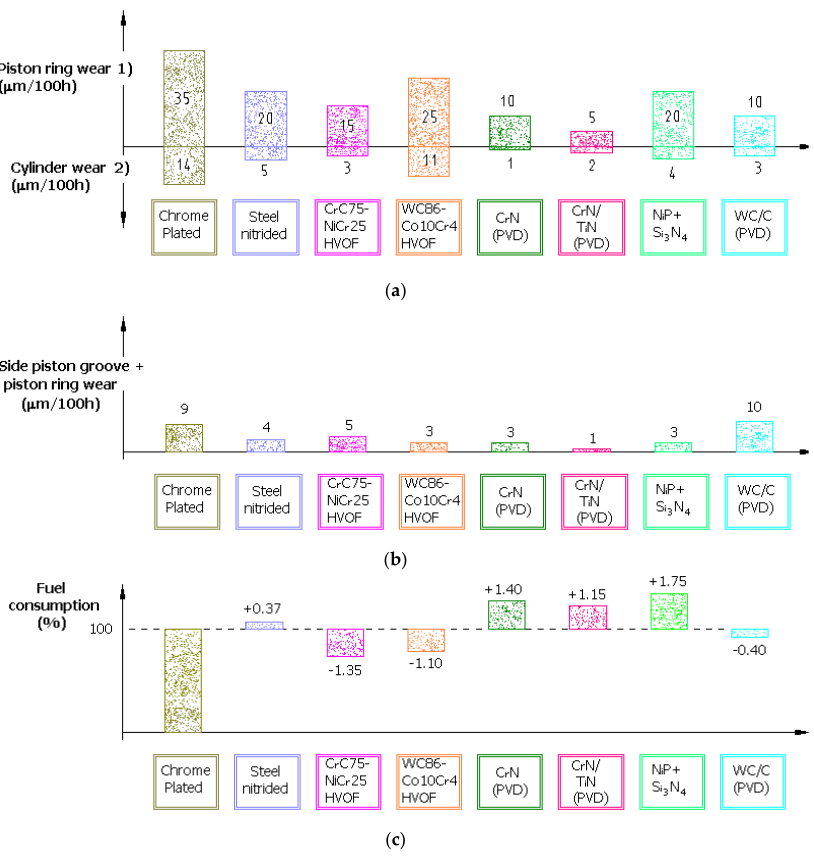
Figure 8. ( a ) Piston ring and cylinder wear under heat endurance test conditions: (1) closed gap increase, (2) bore diameter increase in top dead center position of the first ring. ( b ) Piston ring wear under heat endurance test conditions. ( c ) Fuel consumption measurements, CIE Automotive (Tarabusi).